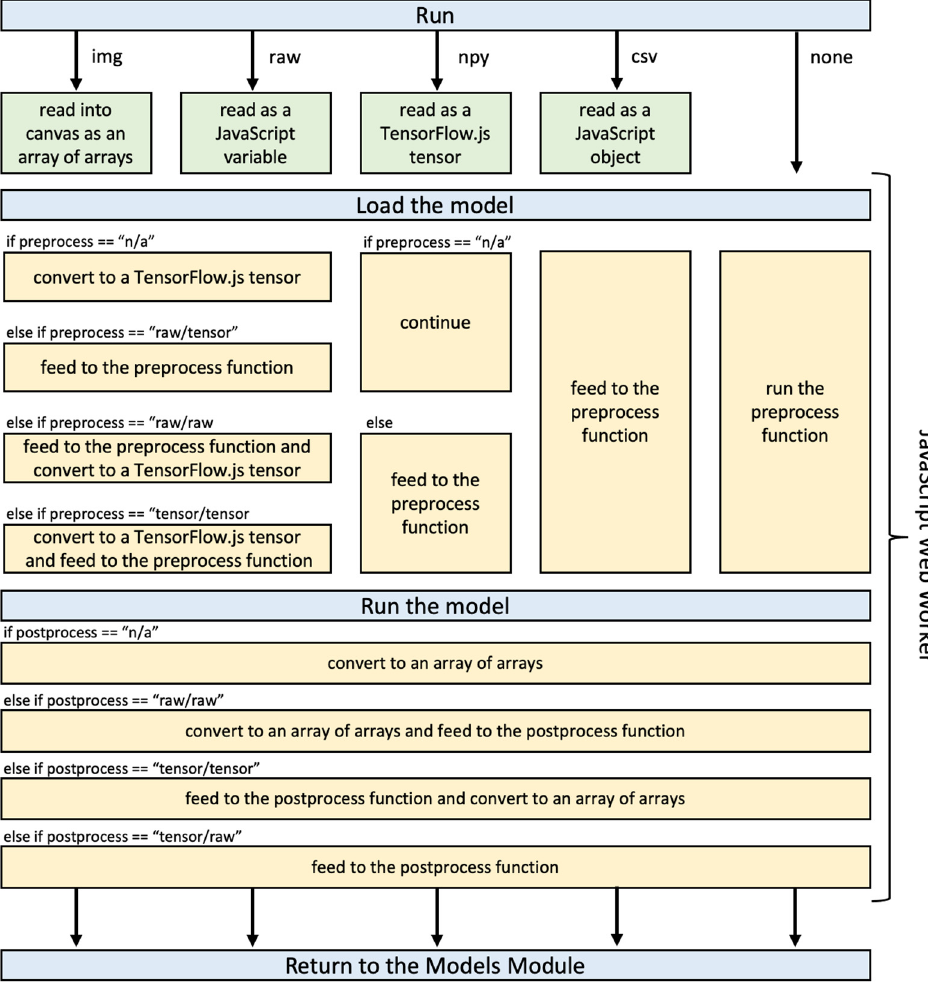
Figure 4. Compute Module schema.